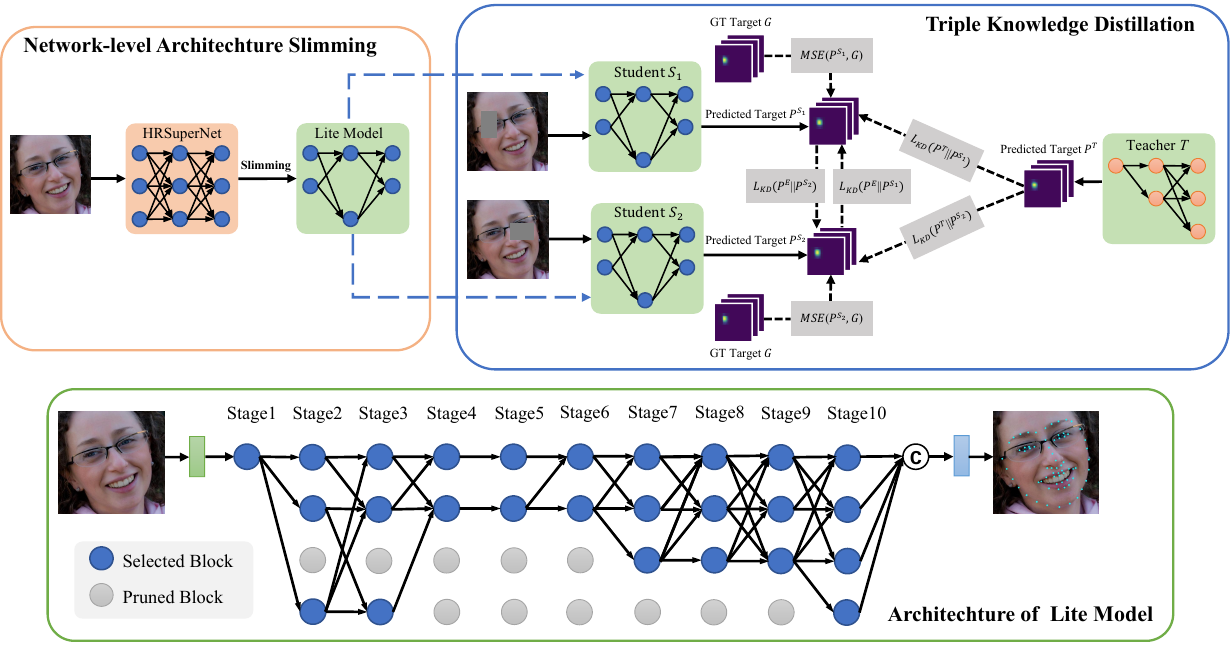
Figure 2. Illustration of the proposed slimming and distillation procedures for face alignment. A lightweight model is first obtained by slimming the HRSuperNet. Then, the lightweight model is refined in a triple knowledge distillation scheme consisting of two peer student networks and a teacher network. We visualize the architecture of the lightweight model trained on the 300W dataset, where the redundant TA operations and LSFF blocks are